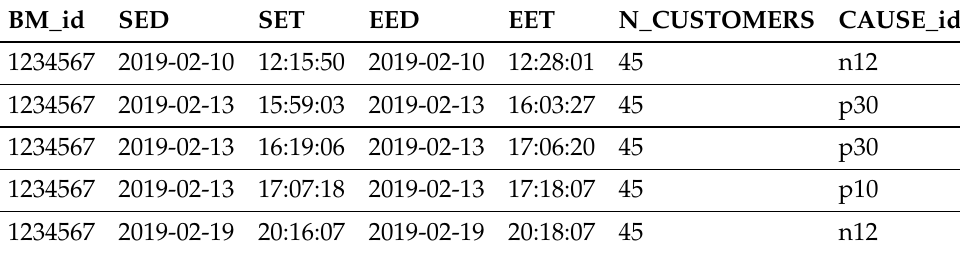
Table 1. Initial steps of the event record of a balancing